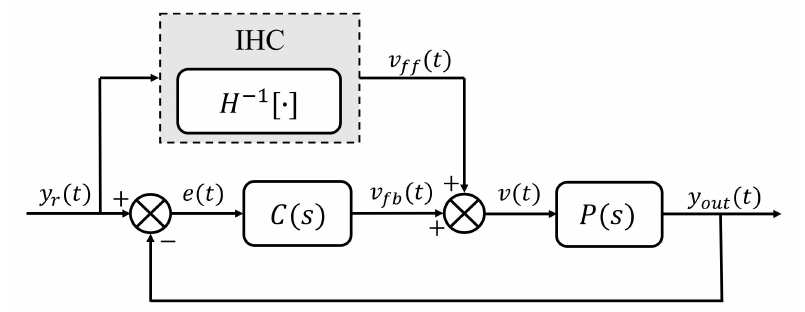
Figure 6. Block diagram of close-loop controller based on